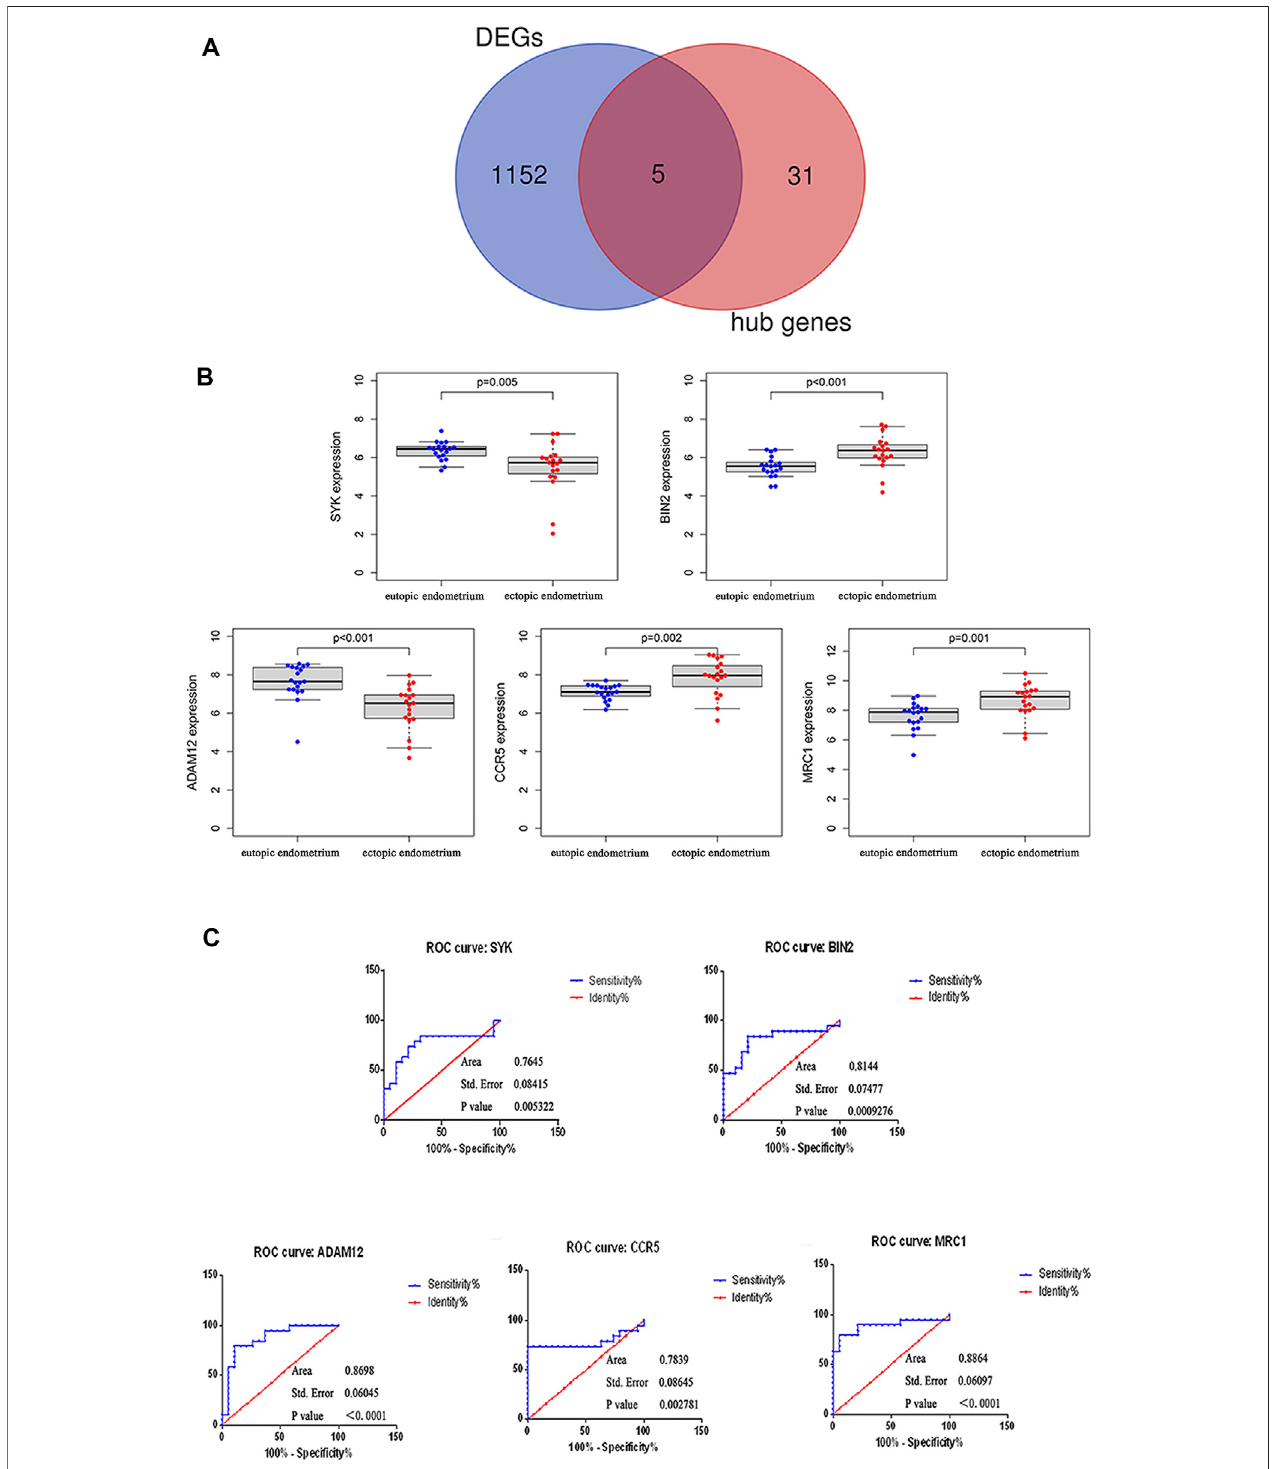
FIGURE 5 | Identi fi cation and validation of the diagnostic values of the key genes. (A) Venn diagram of DEGs and hub genes. Commonly intersecting genes were identi fi ed as key genes, which included SYK, BIN2, ADAM12, CCR5, and MRC1. (B) Differential expression of fi ve key genes between the eutopic endometrium and ectopic endometrium. (C) ROC curves for SYK, BIN2, ADAM12, CCR5, and MRC1.